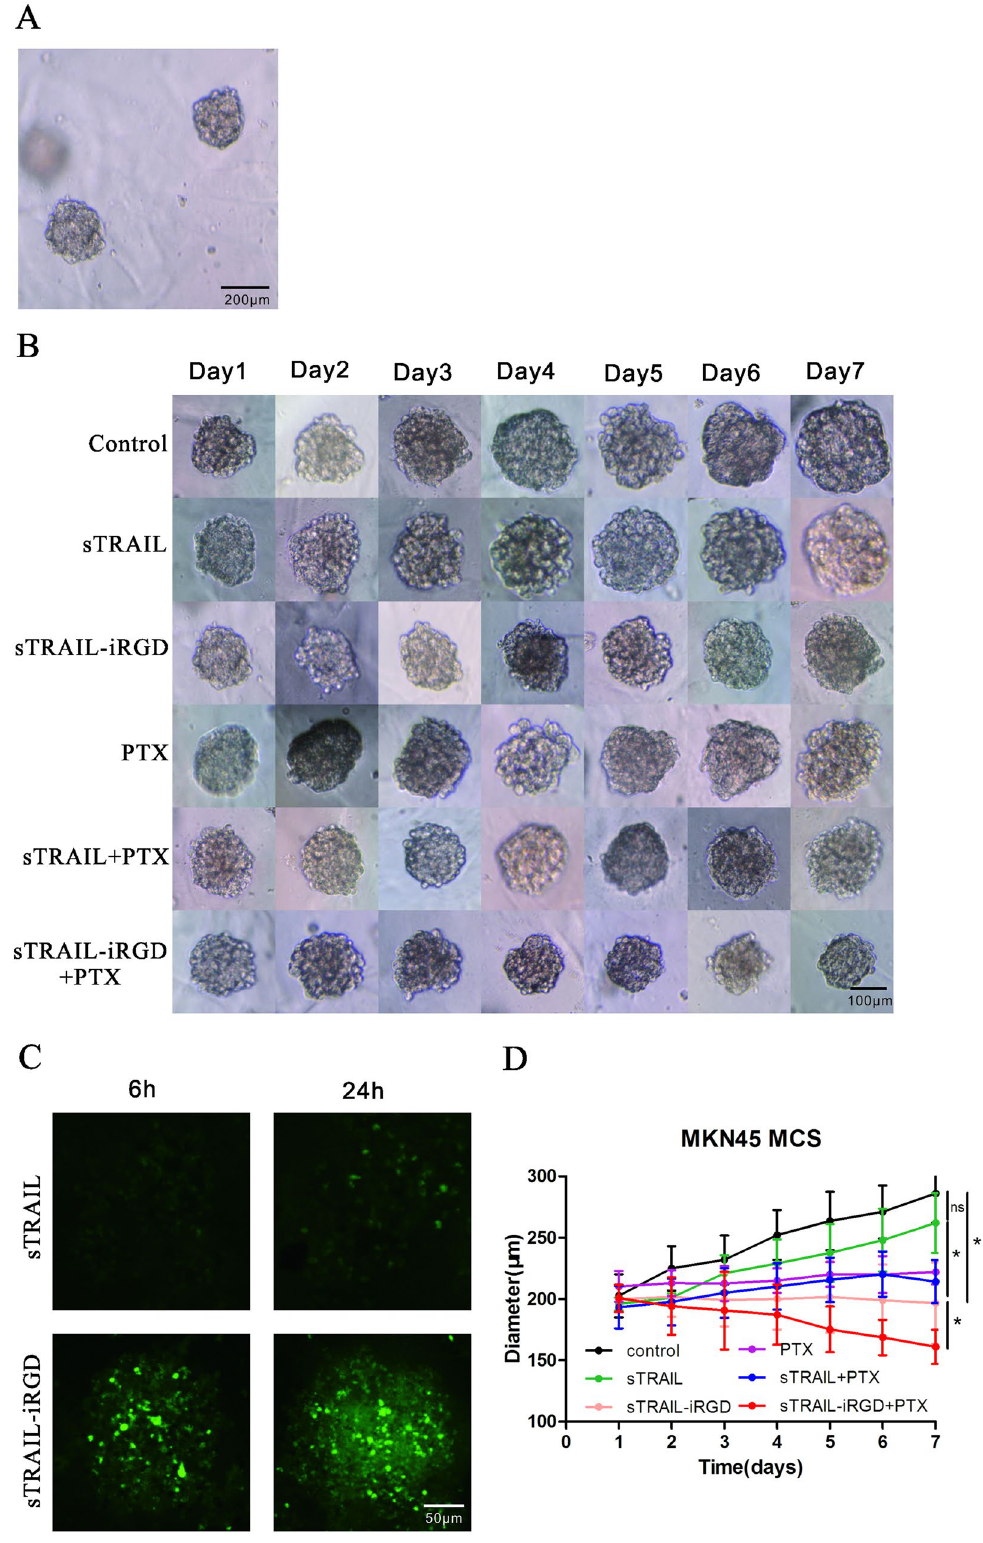
Figure 5. Visualization of MKN45 3D MCS. MKN45 3D MCS captured by optical microscopy (scale bar = 200 μ m). ( A ) Representative images of MCS treated with culture medium, sTRAIL, sTRAIL-iRGD, PTX, sTRAIL + PTX or sTRAIL-iRGD + PTX. ( B ) Control MCS were cultured in RPMI1640 medium alone (scale bar = 100 μ m). LSCM images of MKN45 MCS incubated with FITC-labeled sTRAIL or sTRAIL-iRGD for 6 and 24 h (scale bar = 50 μ m). ( C ) Growth inhibition assay in MKN45 MCS. ( D ) MCS growth curves after treatment. All data are expressed as means ± standard deviation (SD), n = 3. * p <